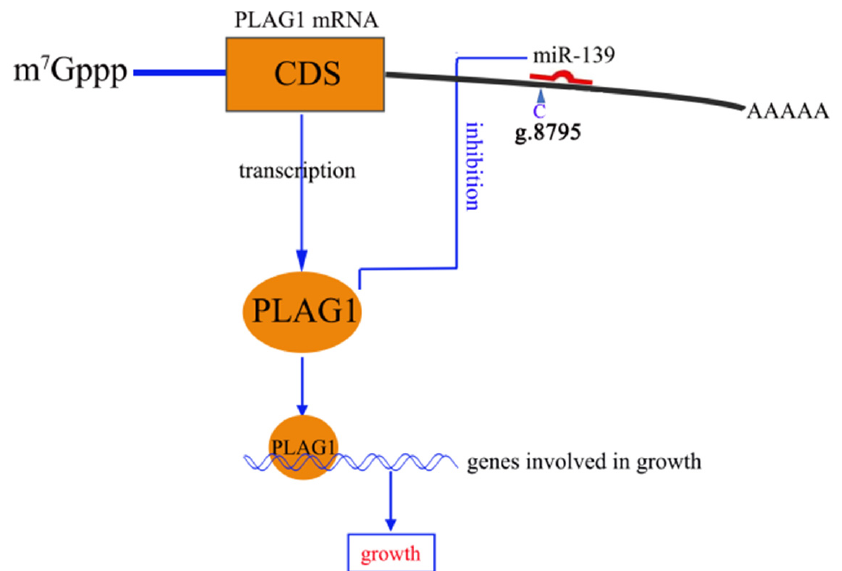
Figure 6. Schematic model depicting the proposed regulation pathway of miR-139-mediated PLAG1 transcription and further growth regulation of Hu sheep: the g.8795C>T mutation weakens the binding activity between miR-139 and PLAG1 3 ′ -UTR, resulting in decreased inhibition of PLAG1 transcription, further increasing the birth and weaning weights of Hu sheep.